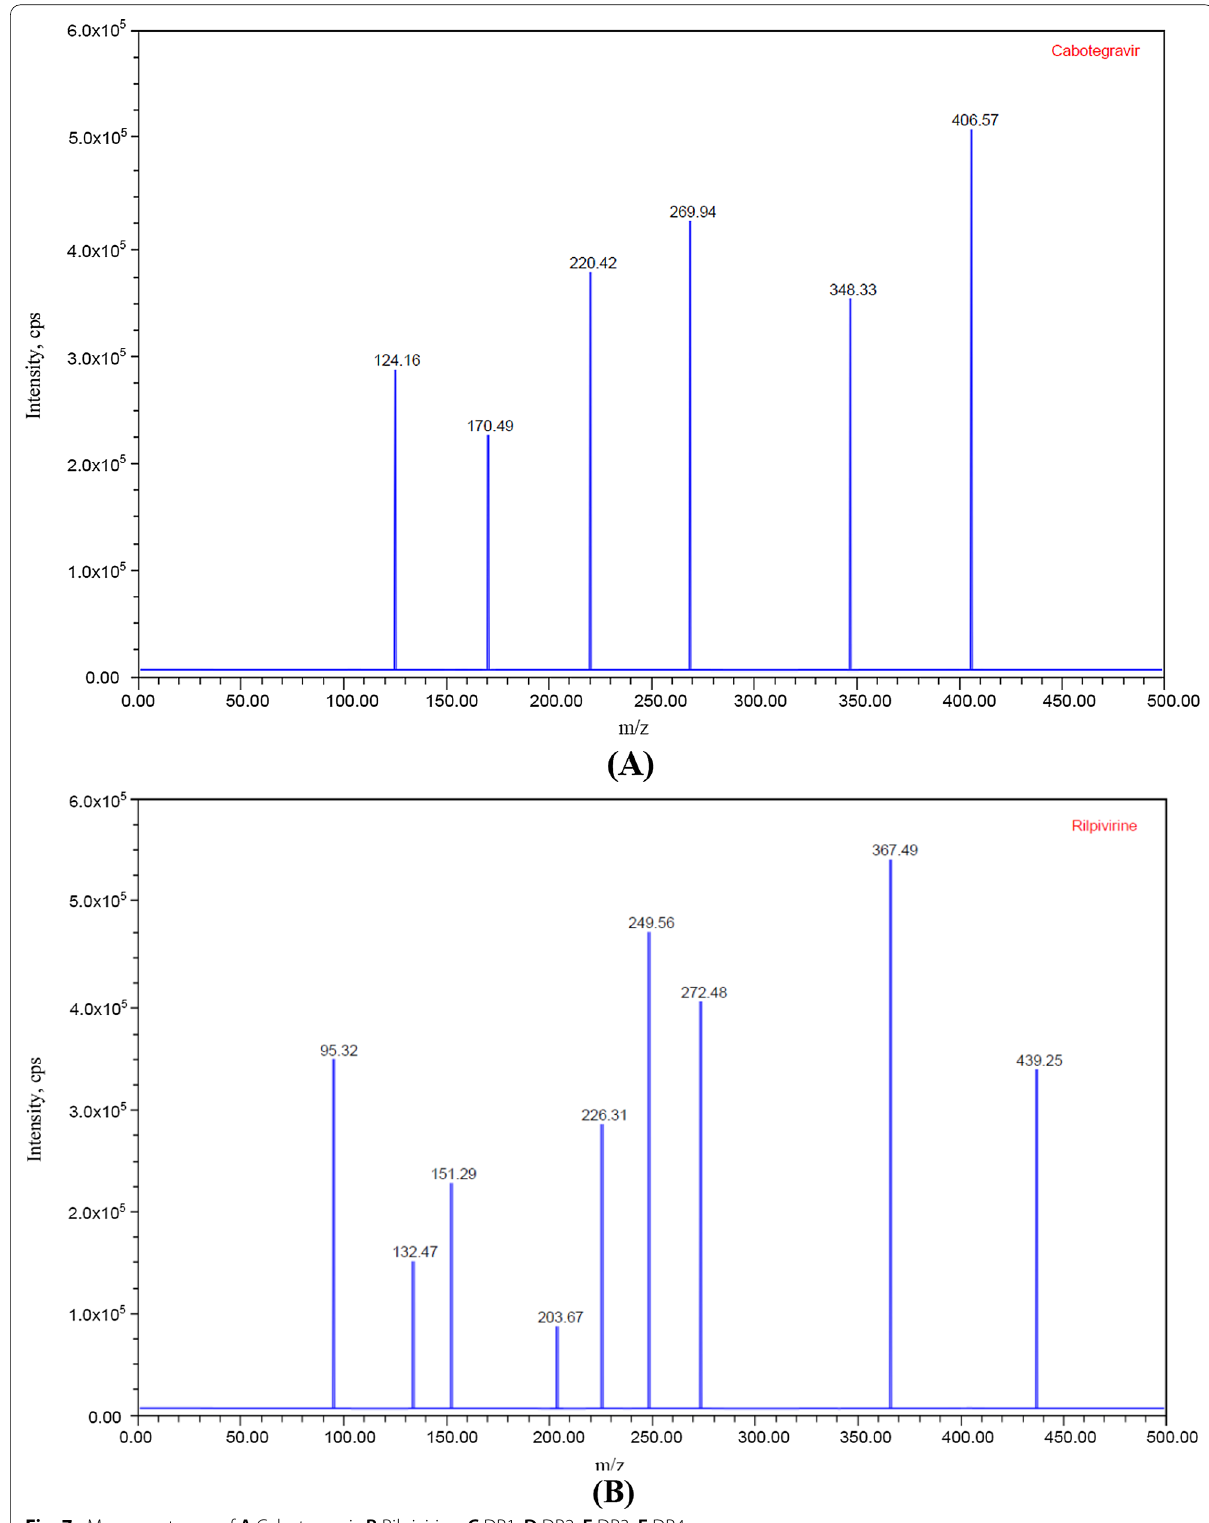
Fig. 7 Mass spectrums of A Cabotegravir, B Rilpivirine, C DP1, D DP2, E DP3, F